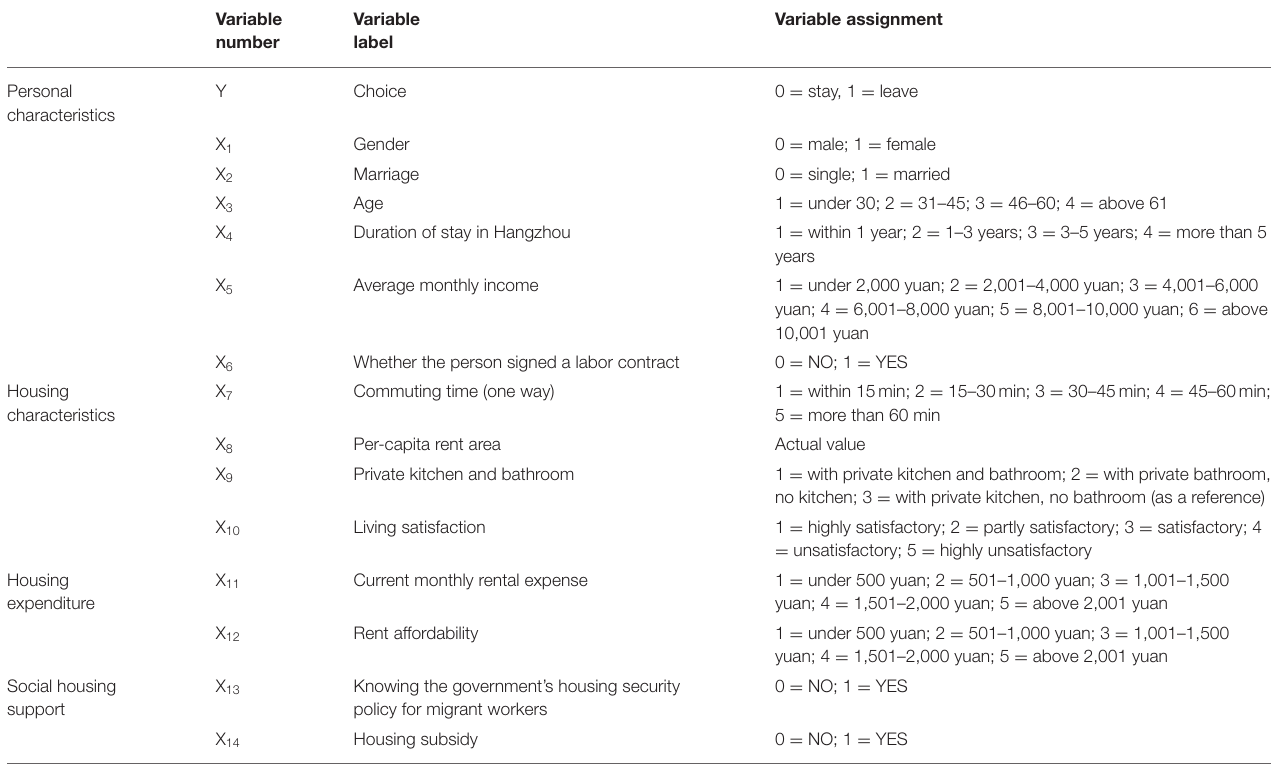
TABLE 5 | The characteristics and descriptions of variables.